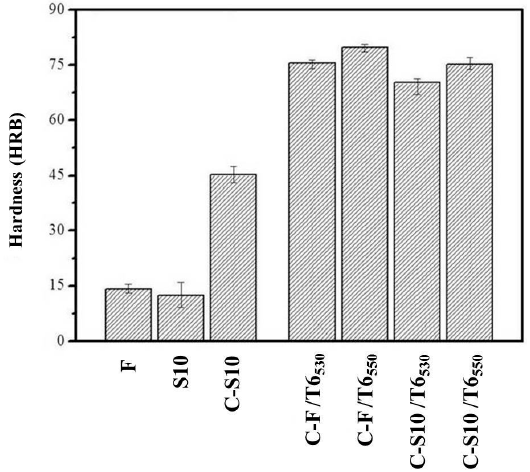
Figure 10. Hardness data of specimens.